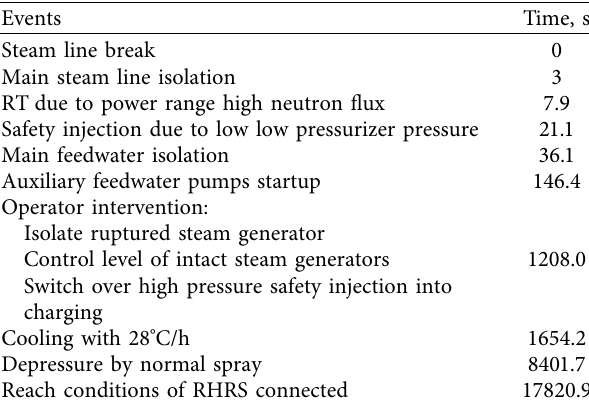
Table 3: Sequence of SLB concurrent with RPMS